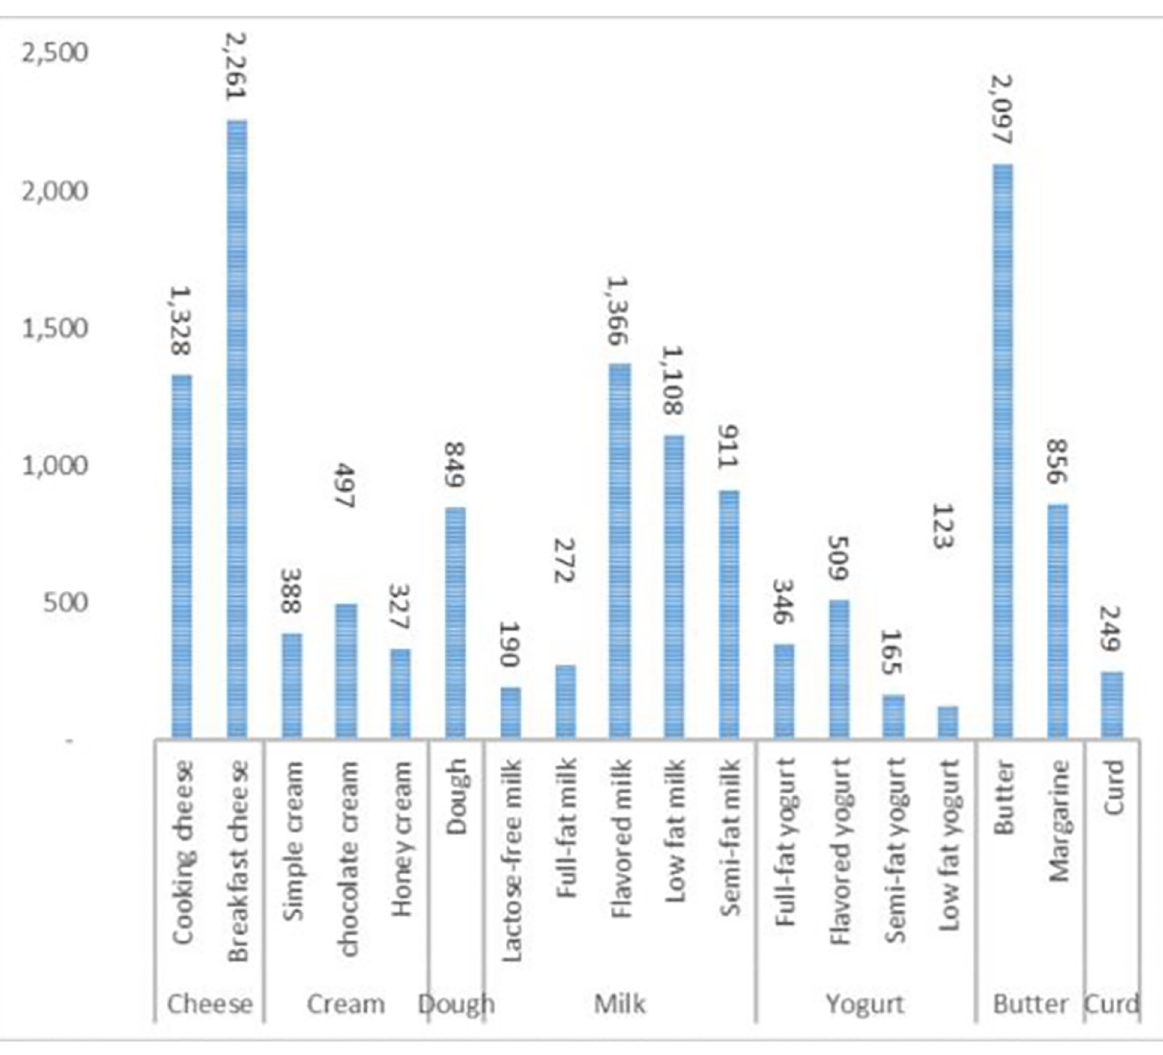
Fig 16. The average inventory for the products in the real